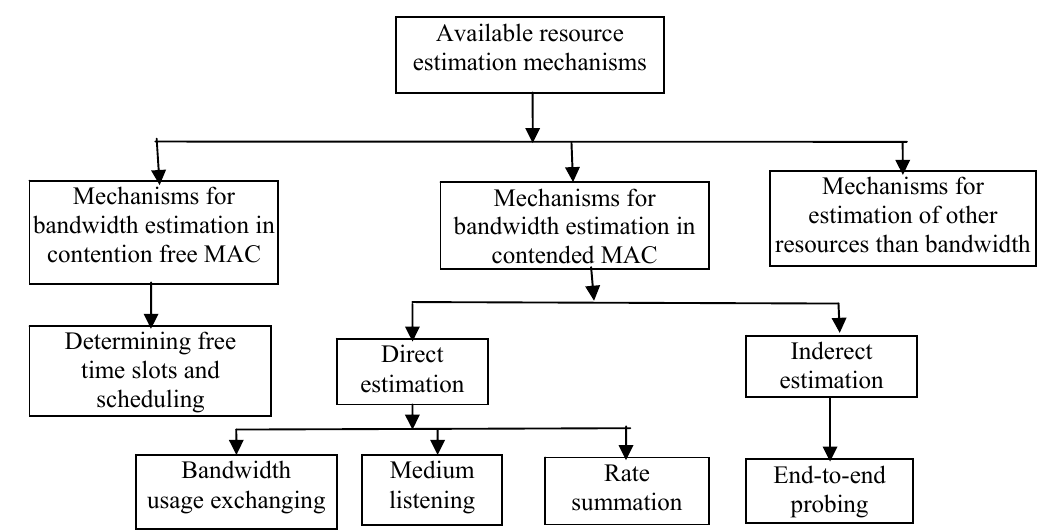
Figure 2. Classification of available resource estimation